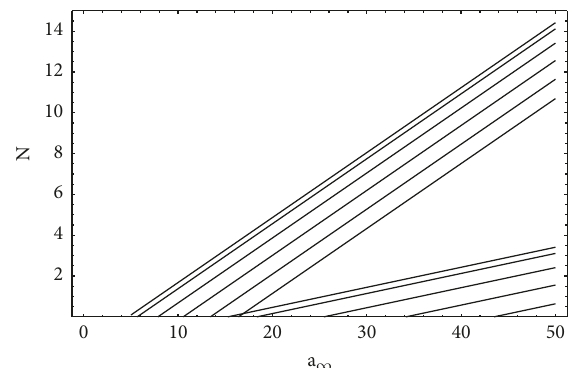
Figure 9: The number of eigenvalues 𝐸 in the positive spectrum versus 𝑎 ∞ for 𝐿 = 0, .. ., 5 . The number increases with 𝐿 . The upper band of lines is for 𝜒 = 1 , and the lower one for 𝜒 = 5 . Obviously the number of eigenvalues increases with the radius of the volume since larger samples allow more oscillations